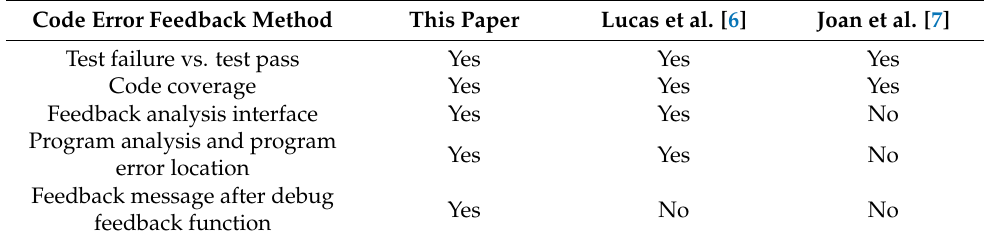
Table 1. Comparison of the findings of this study with those observed in other studies.